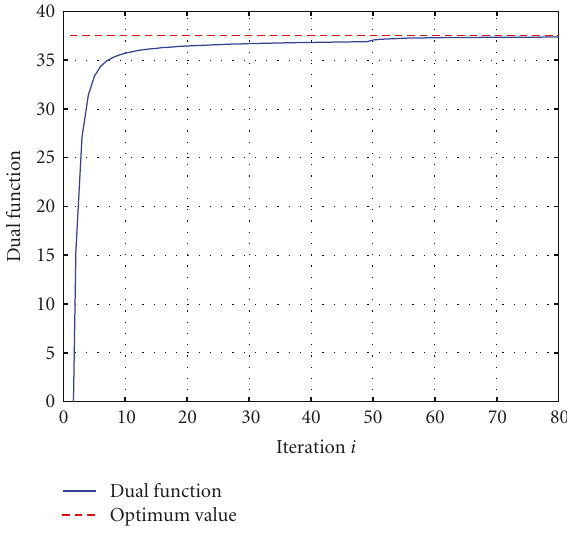
Figure 5: Dual Decomposition: Progress of dual function for [1 3 5 1]